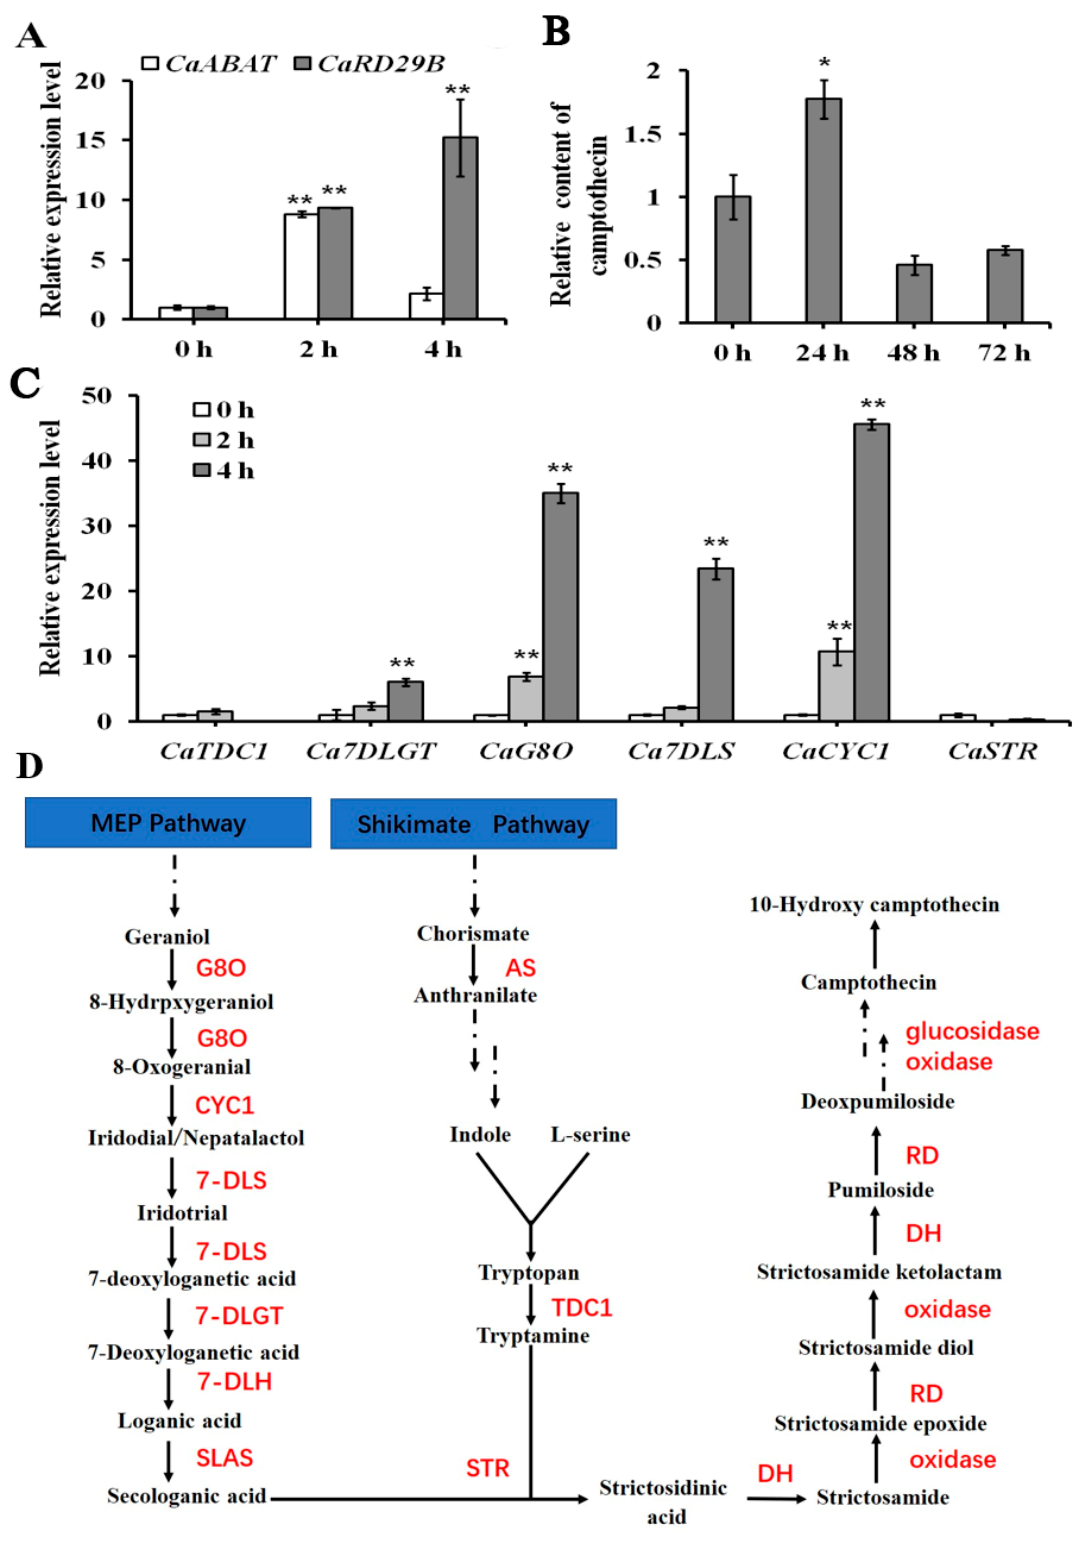
Figure 4. Gene expression and CPT accumulation analysis in response to exogenous ABA treatment in C. acuminata leaves. ( A ) Relative expression levels of CaABAT and CaRD29B in response to ABA treatments. ( B ) Accumulation levels of CPT in response to ABA treatments. ( C ) Relative expression levels of CPT biosynthesis genes in response to ABA treatments. The error bars represent standard deviations from three biological replicates, and asterisks indicate statistically significant differences